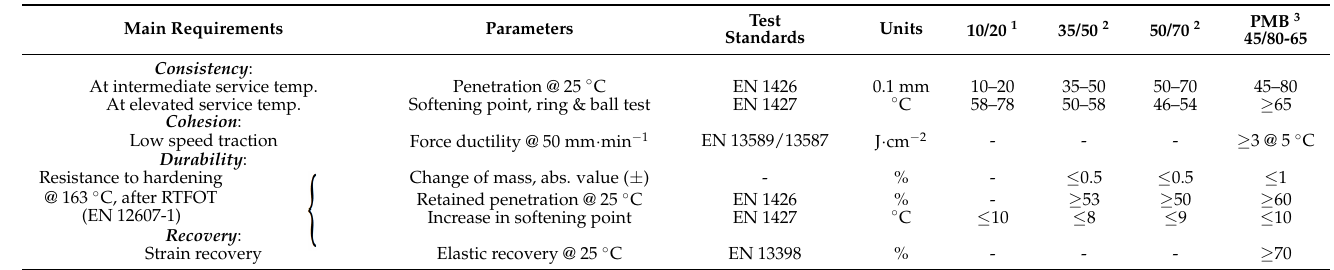
Table 1. Main requirements and standard limits for binders used in this study.